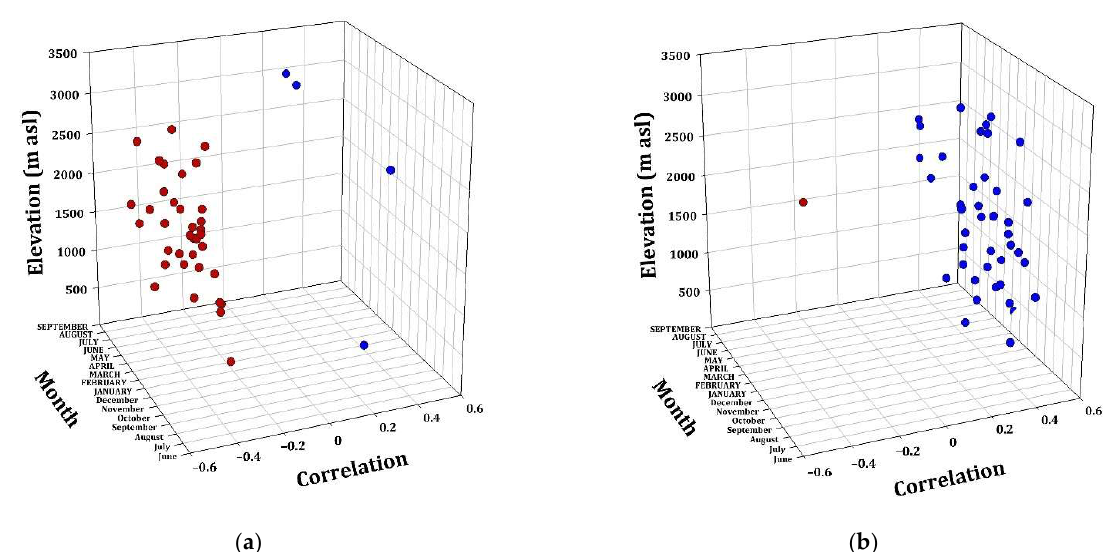
Figure A1. Ecoregions of Mexico.